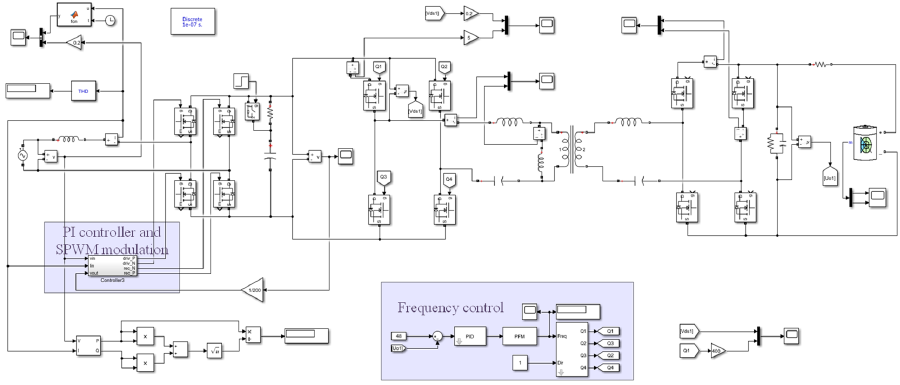
Figure 17. Charging system simulation model.